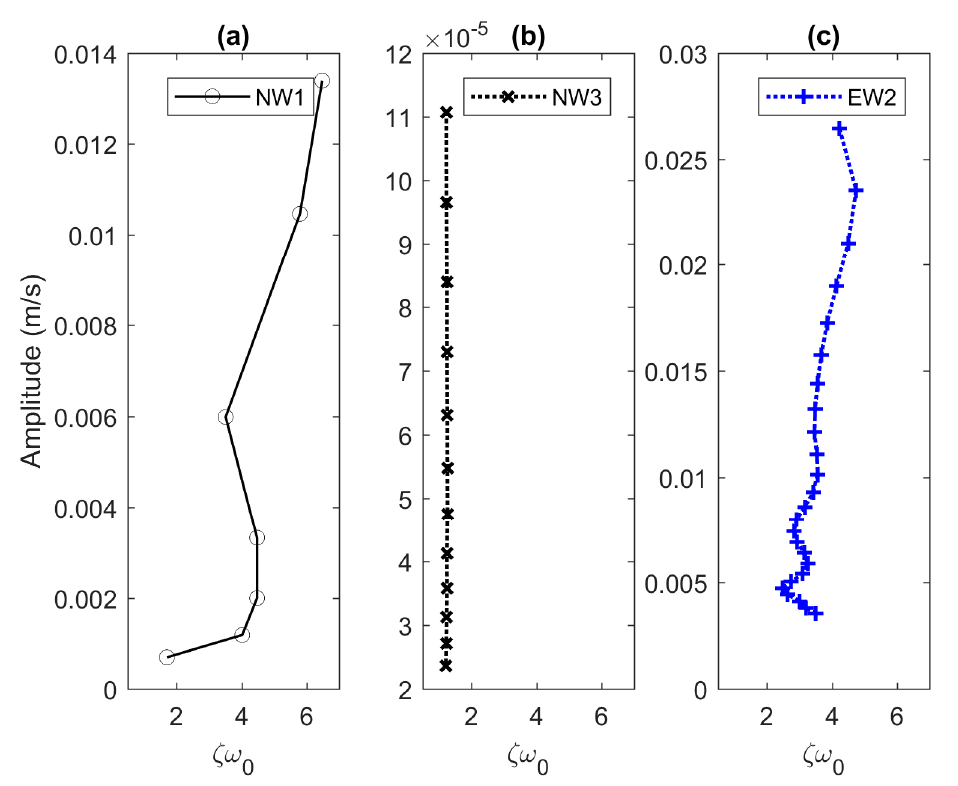
Figure 16. The damping curves extracted from, ( a , b ) the numerical models and ( c ) the experimental models.